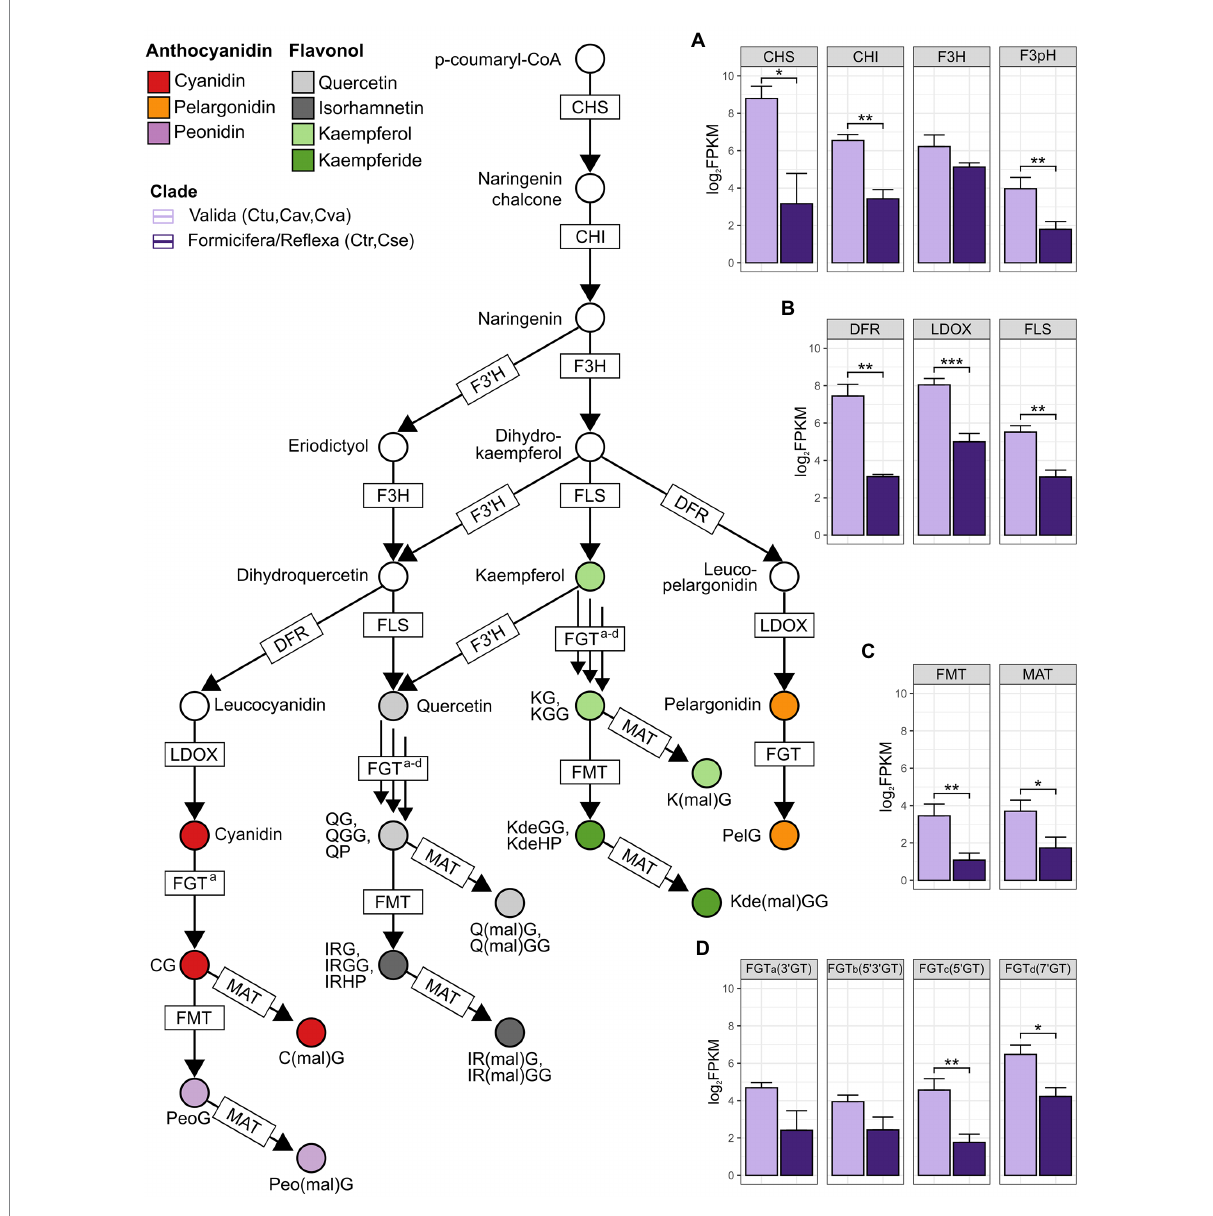
FIGURE 2 Phylogenetic patterns of anthocyanin/flavonol glycoside-related pathway expression of mature flower calli in a cross-section of Chiloglottis orchids. Boxplots from (A–D) depict the general patterns of genes in respective pathway steps across the three clades—REF ( Chiloglottis seminuda ), FOR ( Chiloglottis trapeziformis ), and VAL ( Chiloglottis turfosa , Chiloglottis aff. valida , Chiloglottis valida ). Asterisks indicate significant differences in the total gene expression between clade comparisons at p < 0.05 (*), p < 0.01 (**), and p < 0.001 (***) based on ANOVA and Tukey’s HSD test. See Supplementary Table S3 for full gene names and predicted function of corresponding gene